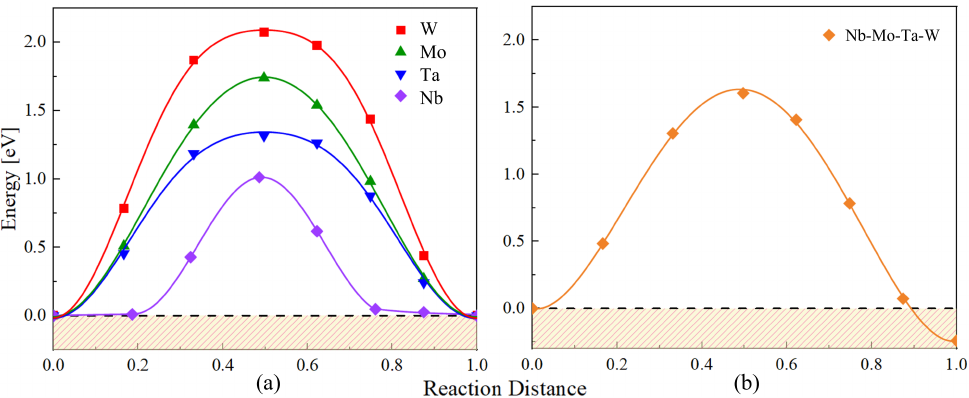
Figure 6. The minimum energy path of vacancy migration in ( a ) pure constituent metals and ( b ) the equiatomic random Nb-Mo-Ta-W. The dashed line and the shadow region indicate the initial energy and energies below,